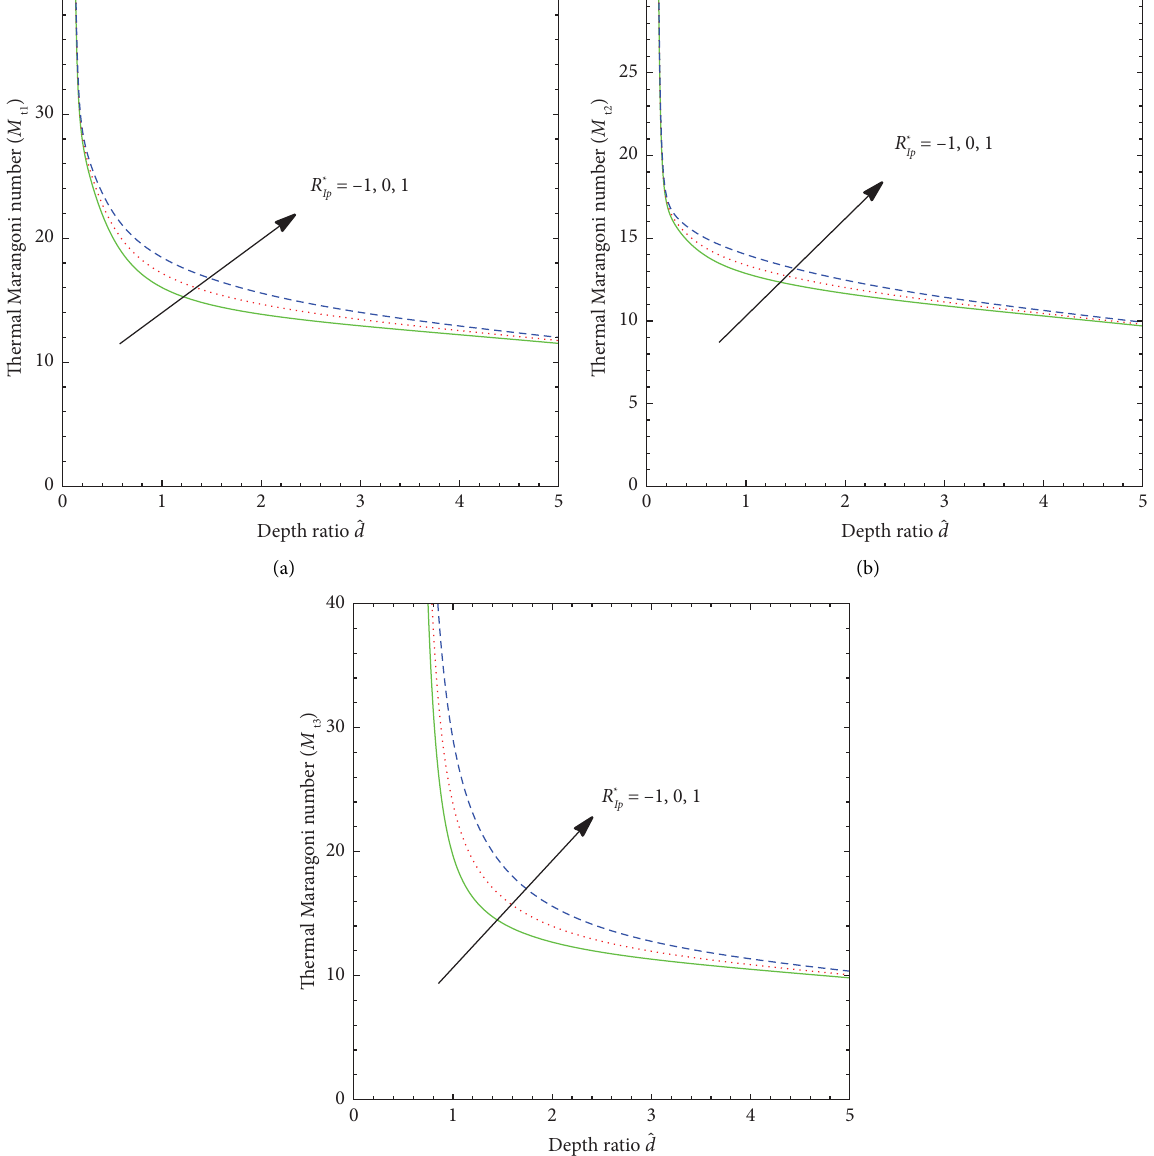
� − 1 , 0 , 1 efects in region-2 when a Ip